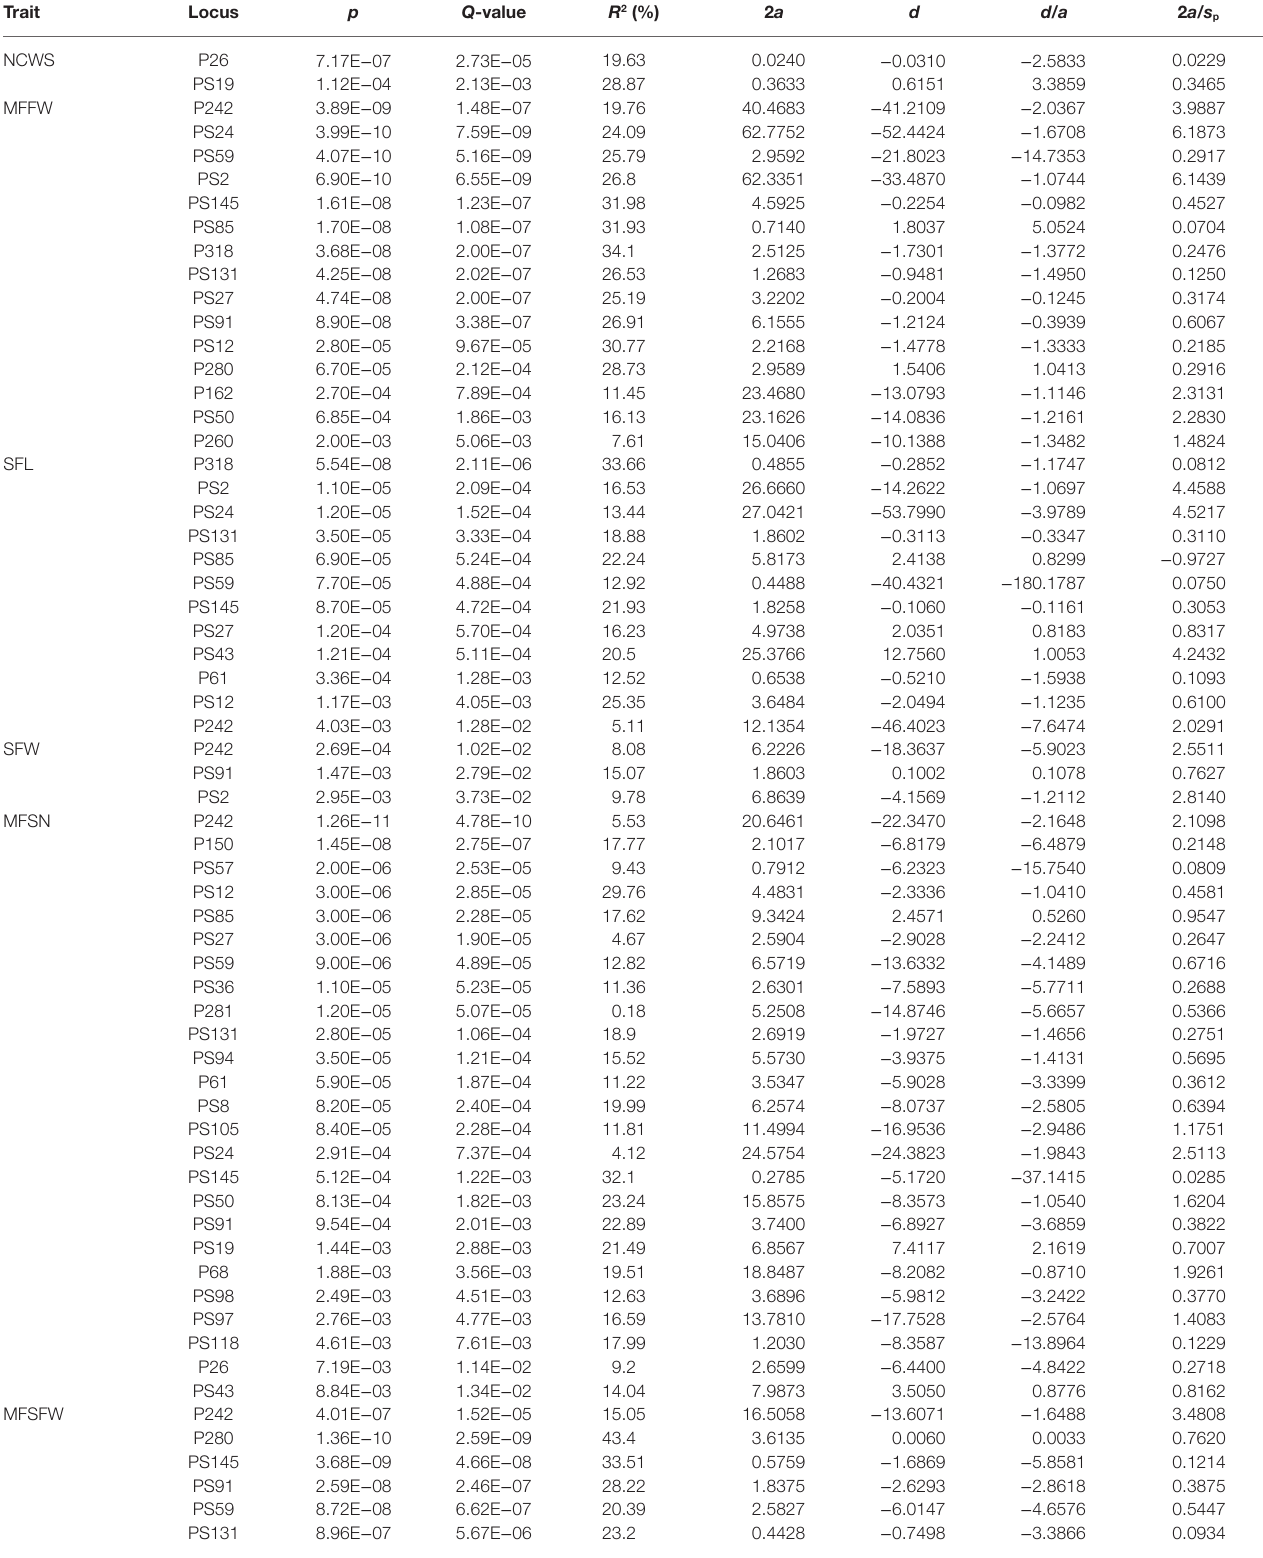
TABLE 5 | Significant SSR marker-trait pairs from the association test results of fruit traits. Trait Locus p Q